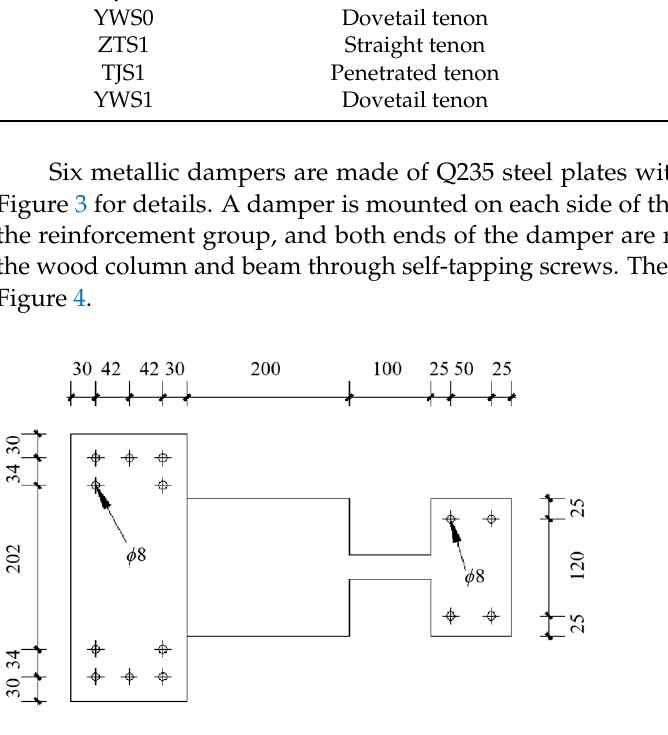
Figure 3. Dimensions of metallic dampers (unit: mm).